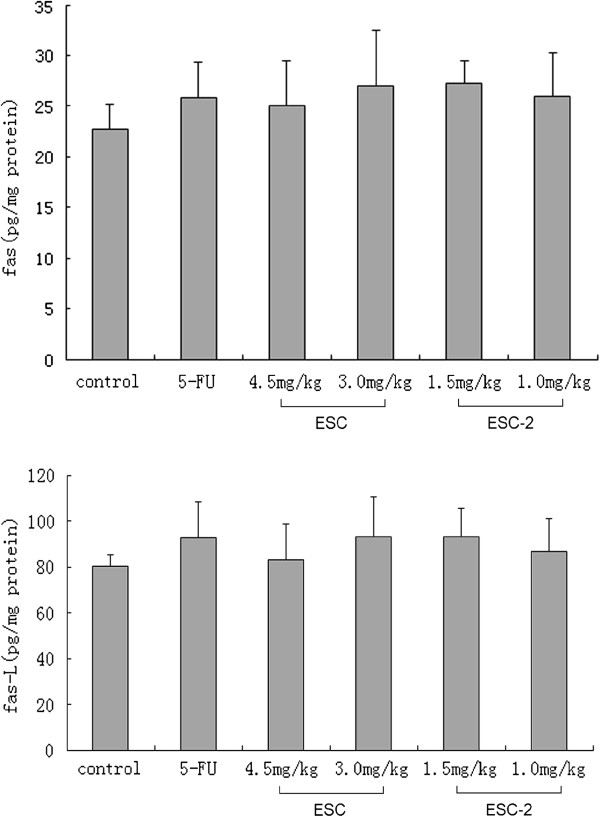
Influence of ESCs on expression of Fas and Fas-L in NCI-H460 cells from implanted hollow fibers. The data were expressed as mean ± SD (n = 6 per group). ESCs treatment groups has no significant change versus control group.